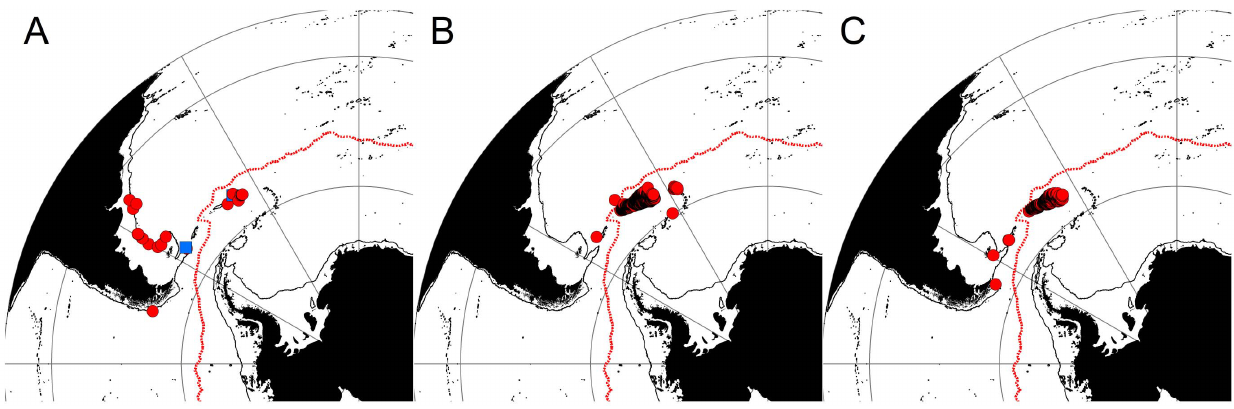
Figure 6. Crab and lobster species shared only between Southern South America and the northern Scotia arc. Thymops takedai (A – Blue Square), Thymops birsteini (A – Red circle), Paralomis formosa (B) and Paralomis spinosissima (C). Red line=Mean position of Polar Front (Moore